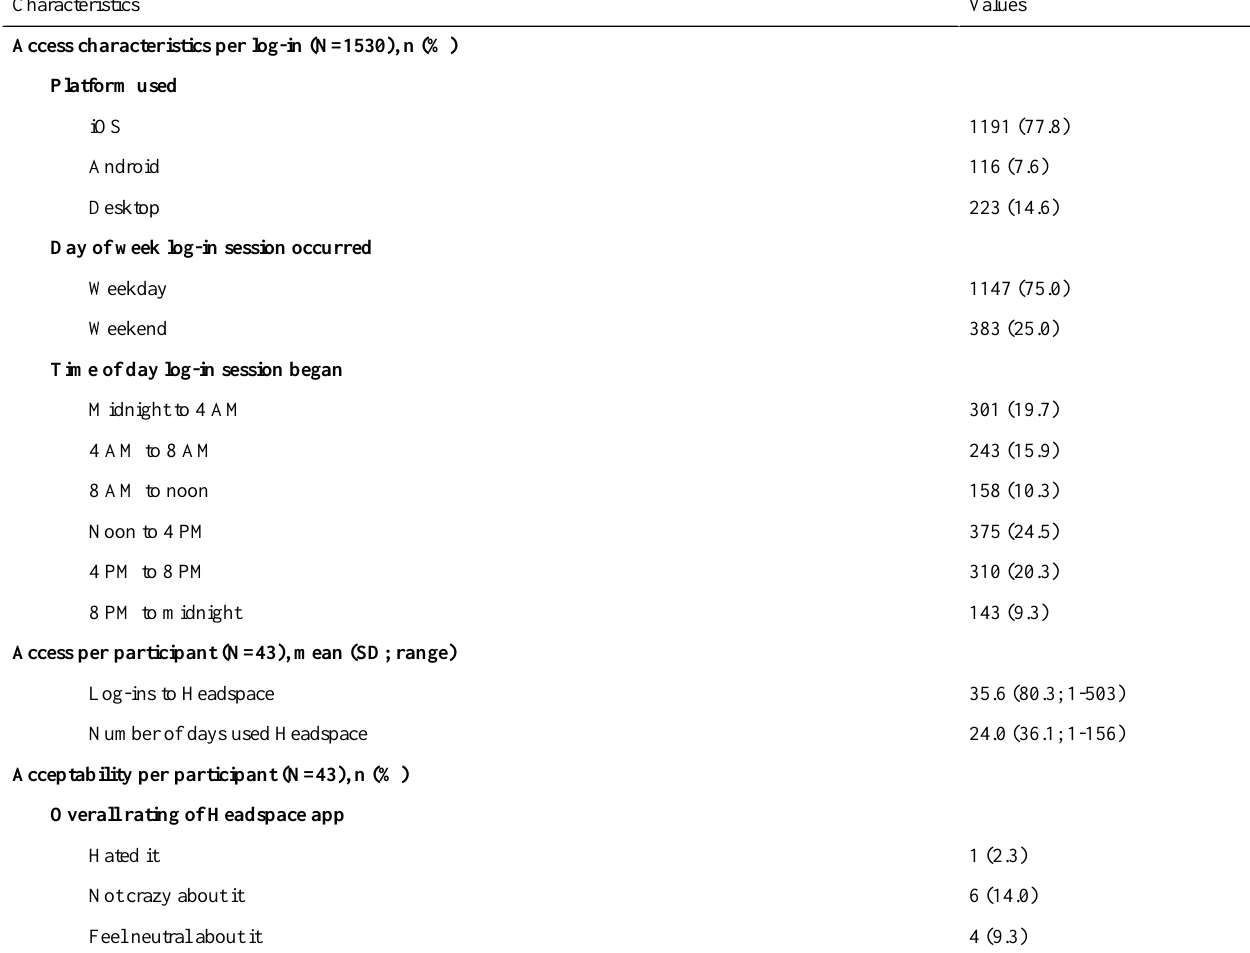
Table 2. Characteristics of Headspace usage among participants.